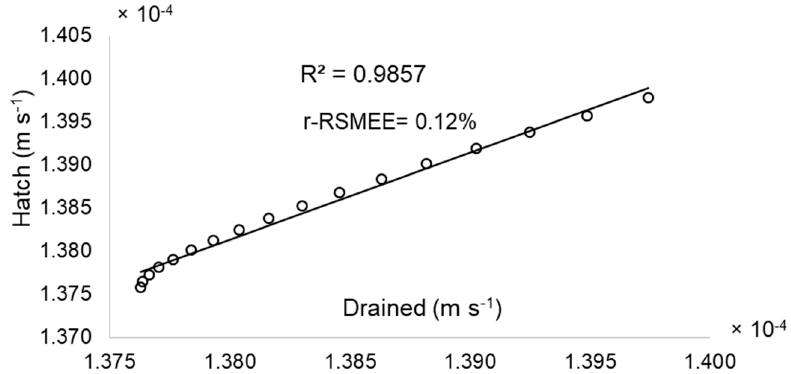
Figure 8. Correlation between Hatch water flux rates and Drained water flux rates.